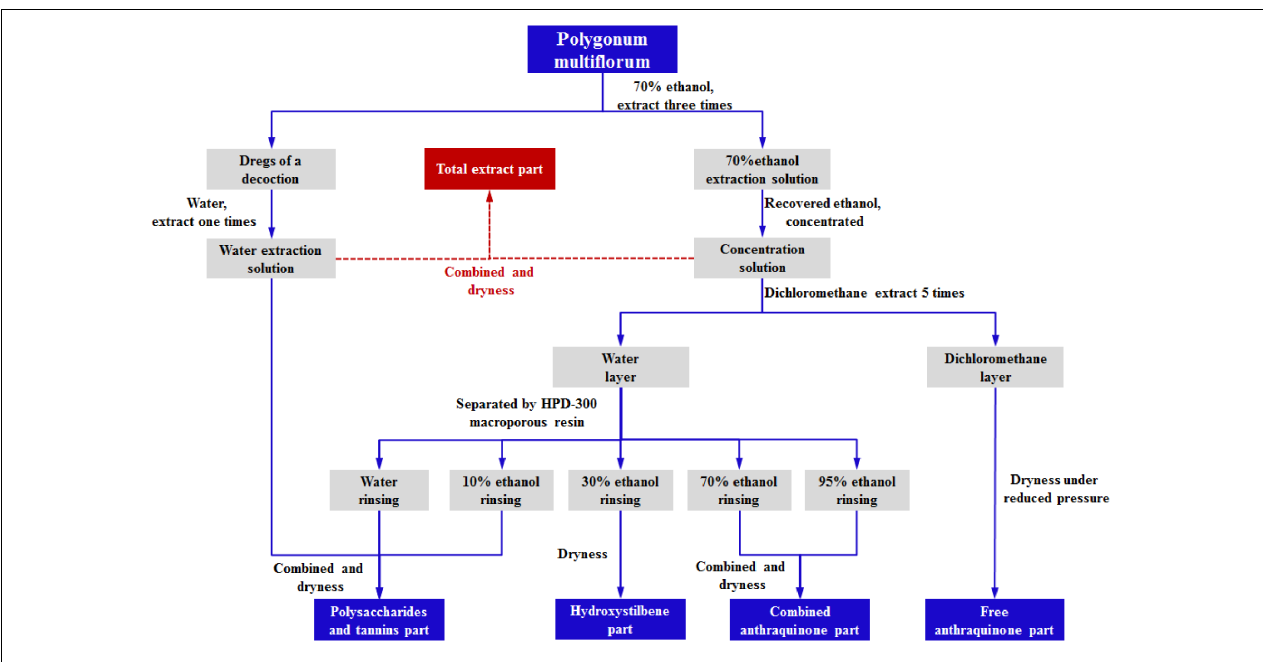
FIGURE 1 | The process of the extraction of PM.